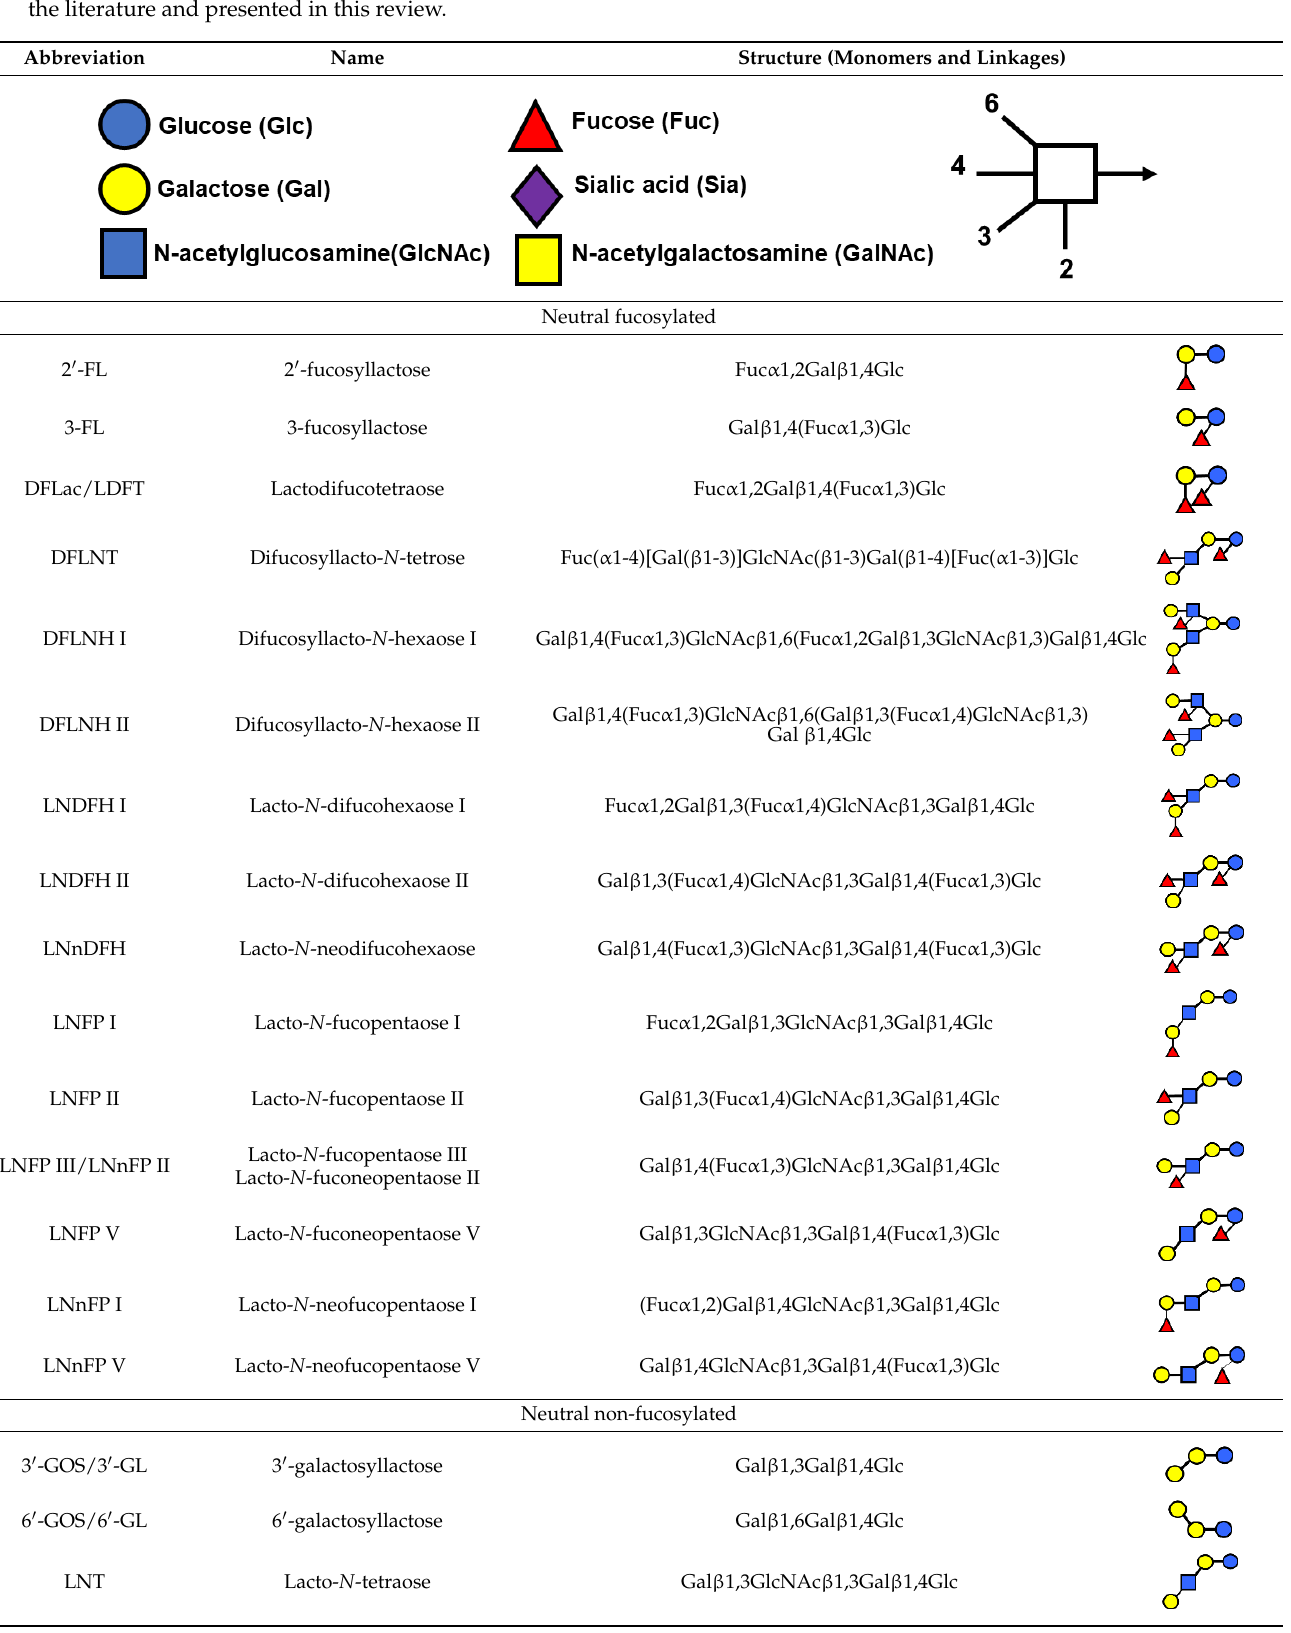
Table 1. List of abbreviations of the most common HMO compounds with their chemical names and structures described in the literature and presented in this review.